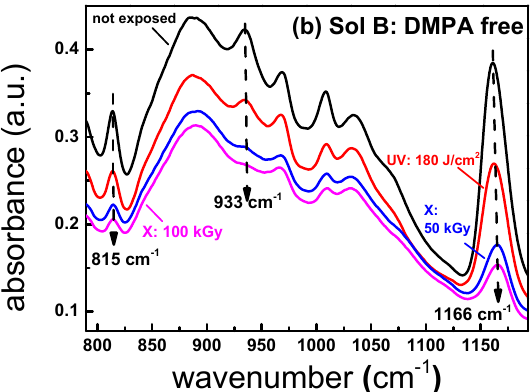
Figure 6. FTIR spectra of sol A with the 2,2-dimethoxy-2-phenylacetophenone (DMPA) photo-initiator ( a ) and sol B without DMPA ( b ). Both cases represent the non-exposed films (black), the UV-exposed films at 180 J / cm 2 (red), and the X-ray-exposed films at 50 kGy (blue) and 100 kGy (magenta).